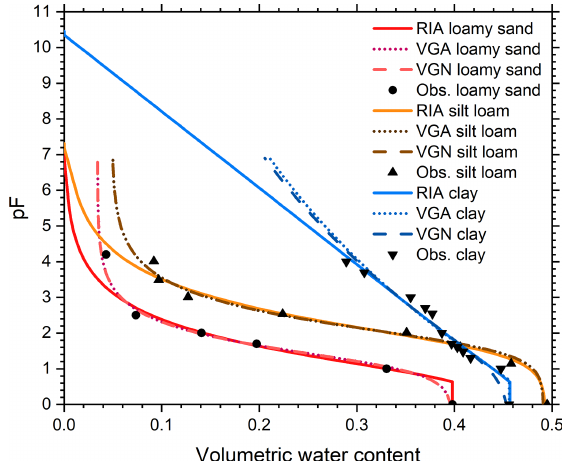
Figure 1. Soil water retention data of the soils used in the numeri- cal simulations, and the retention curves fitted to these data for three parameterizations with a sigmoid midsection of the curve, including the original model by van Genuchten (1980; VGN), the modifica- tion thereof by Ippisch et al. (2006; VGA), and a further modifica- tion introduced in this paper